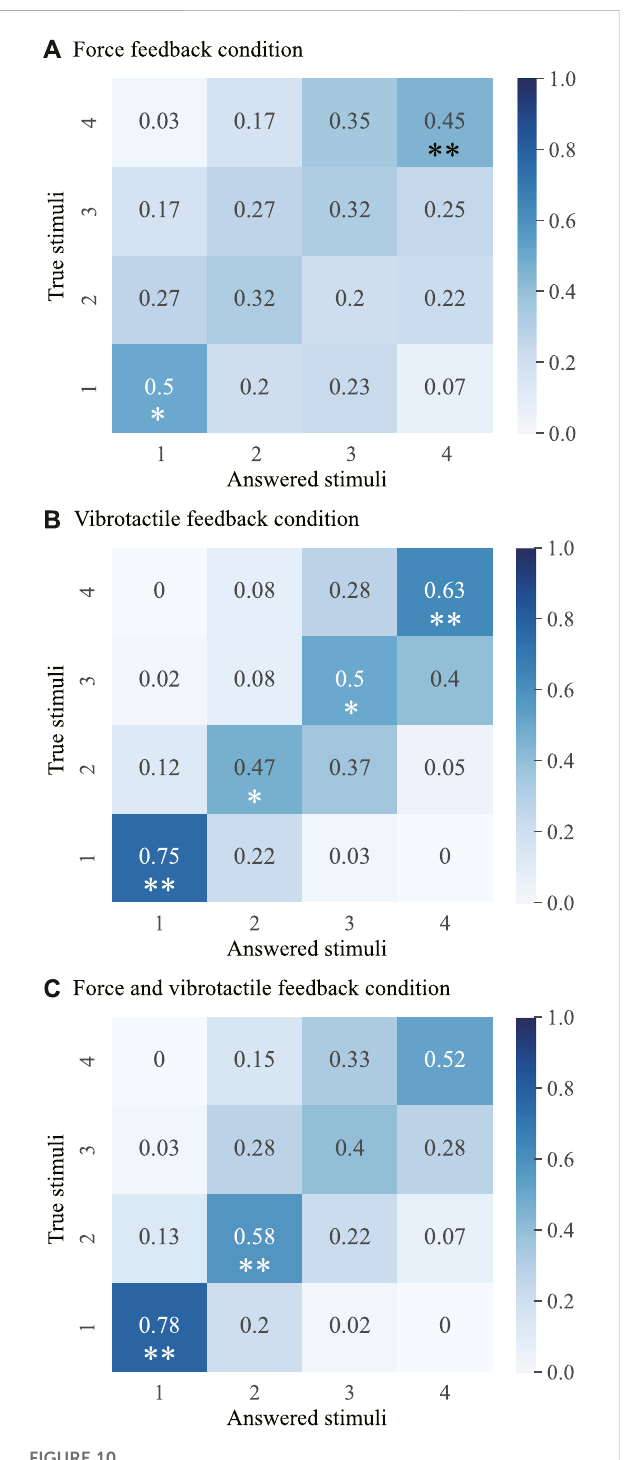
Confusion matrix for the material roughness discrimination using stroke touch mode. 1: roughest, 4: smoothest. (A) Force feedback condition. (B) Vibrotactile feedback condition. (C) Force and vibrotactile feedback condition. *: Bonferroni-adjusted p < 0.0125, **: Bonferroni-adjusted p <